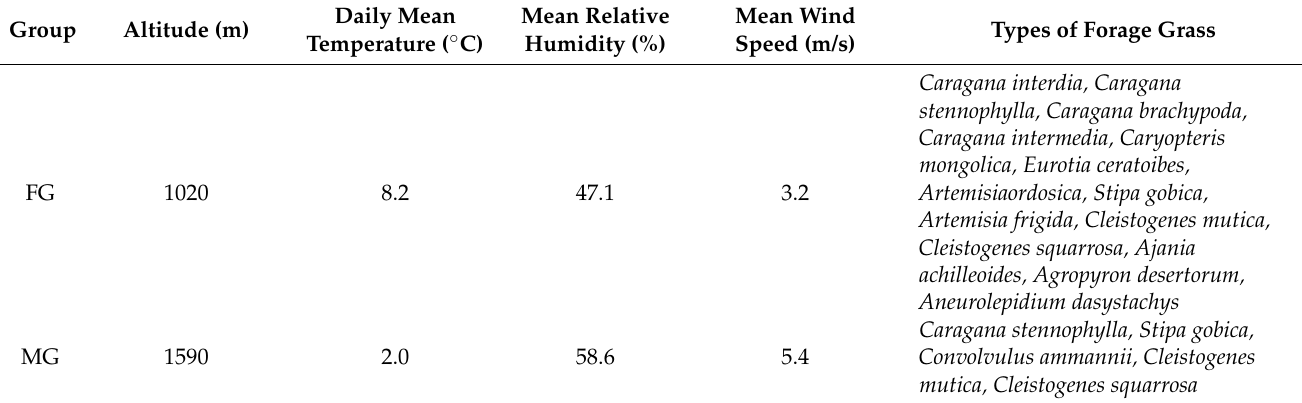
Table 1. Climatic characteristics of two areas in Bayan Nur City, Inner Mongolia Autonomous Region.